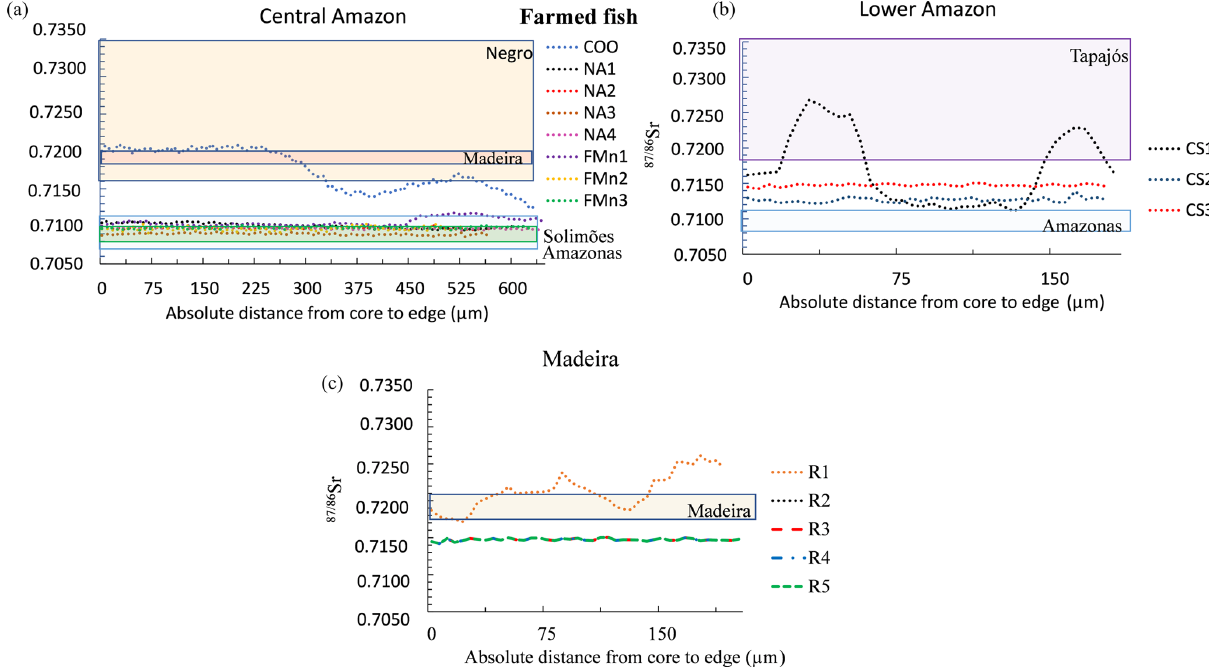
Figure 5. Variation of 87 Sr / 86 Sr measured by LAfs-MC-ICPMS on farmed fish otolith cores – edge transects. Only the final part of the tran- sect (approximately one-third) is represented. Individual fishes were grouped by geographic region: (a) Central Amazon (Manaus Market); (b) Lower Amazon (Santarém Market); (c) Madeira (Ariquemes farm). Note that individuals R2, R3, R4, and R5 present the same 87 Sr / 86 Sr profile. The range of 87 Sr / 86 Sr of river water dissolved matter for each geographic region is indicated by a colored rectangle (based on literature and additional analyses, see Appendix Table A1).